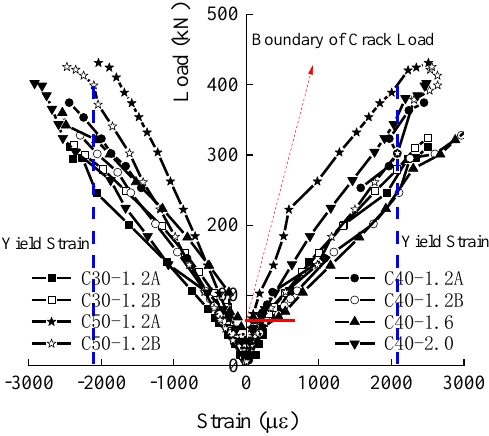
Figure 8. The load-reinforced steel strain curves.